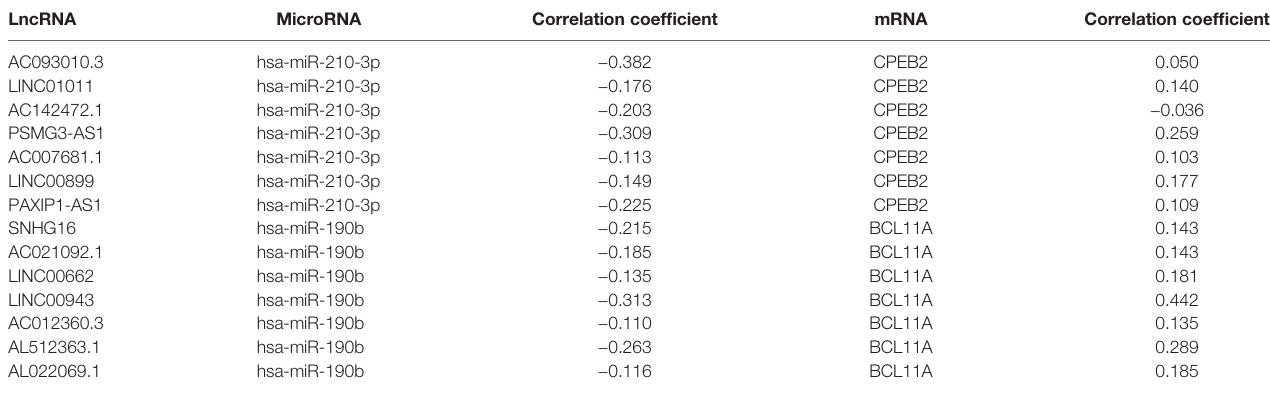
TABLE 4 | The correlation coef fi cient of lncRNA-microRNA and lncRNA-mRNA in TCGA BRCA. LncRNA MicroRNA Correlation coef fi cient